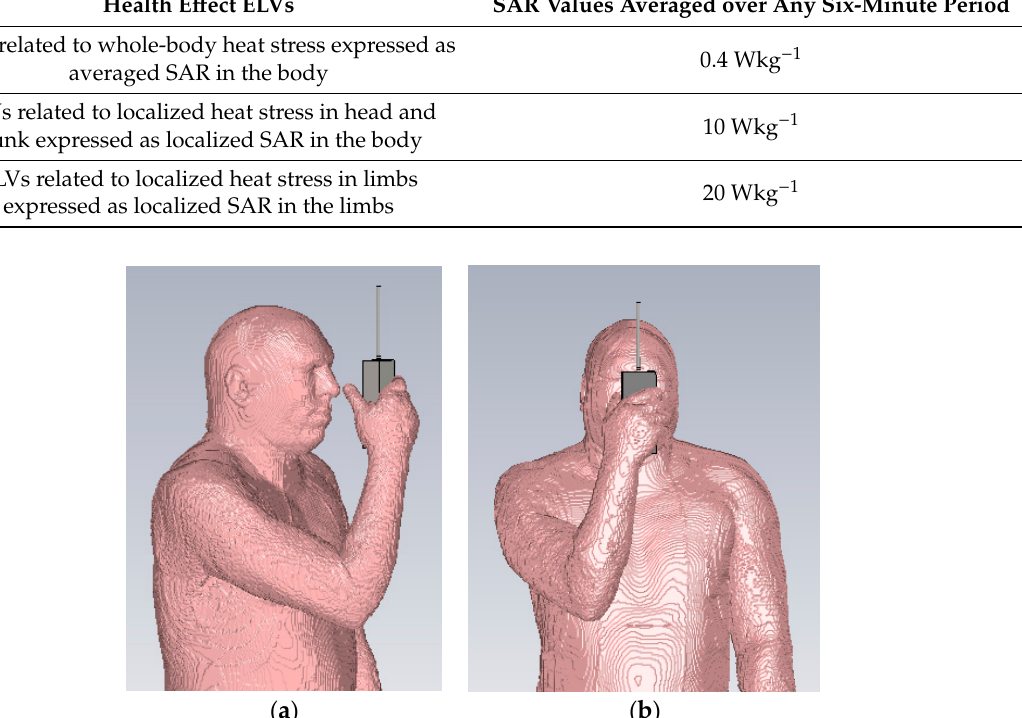
Table 1. The health e ff ect ELVs for exposure to an electromagnetic field from 100 kHz to 6 GHz according to Directive 2013 / 35 / EU [12]. SAR Values Averaged over Any Six-Minute Period